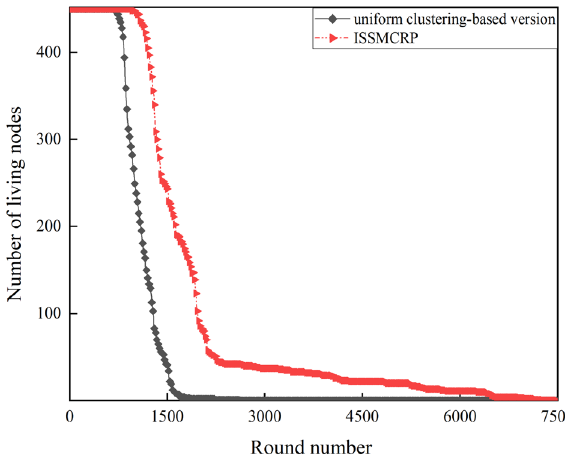
Figure 10. Benefit verification of uneven clustering in ISSMCRP.